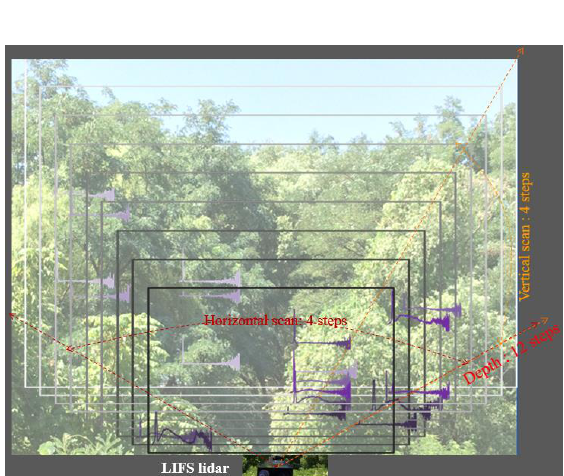
Fig. 5 Distribution map of the fluorescence spectrum of a